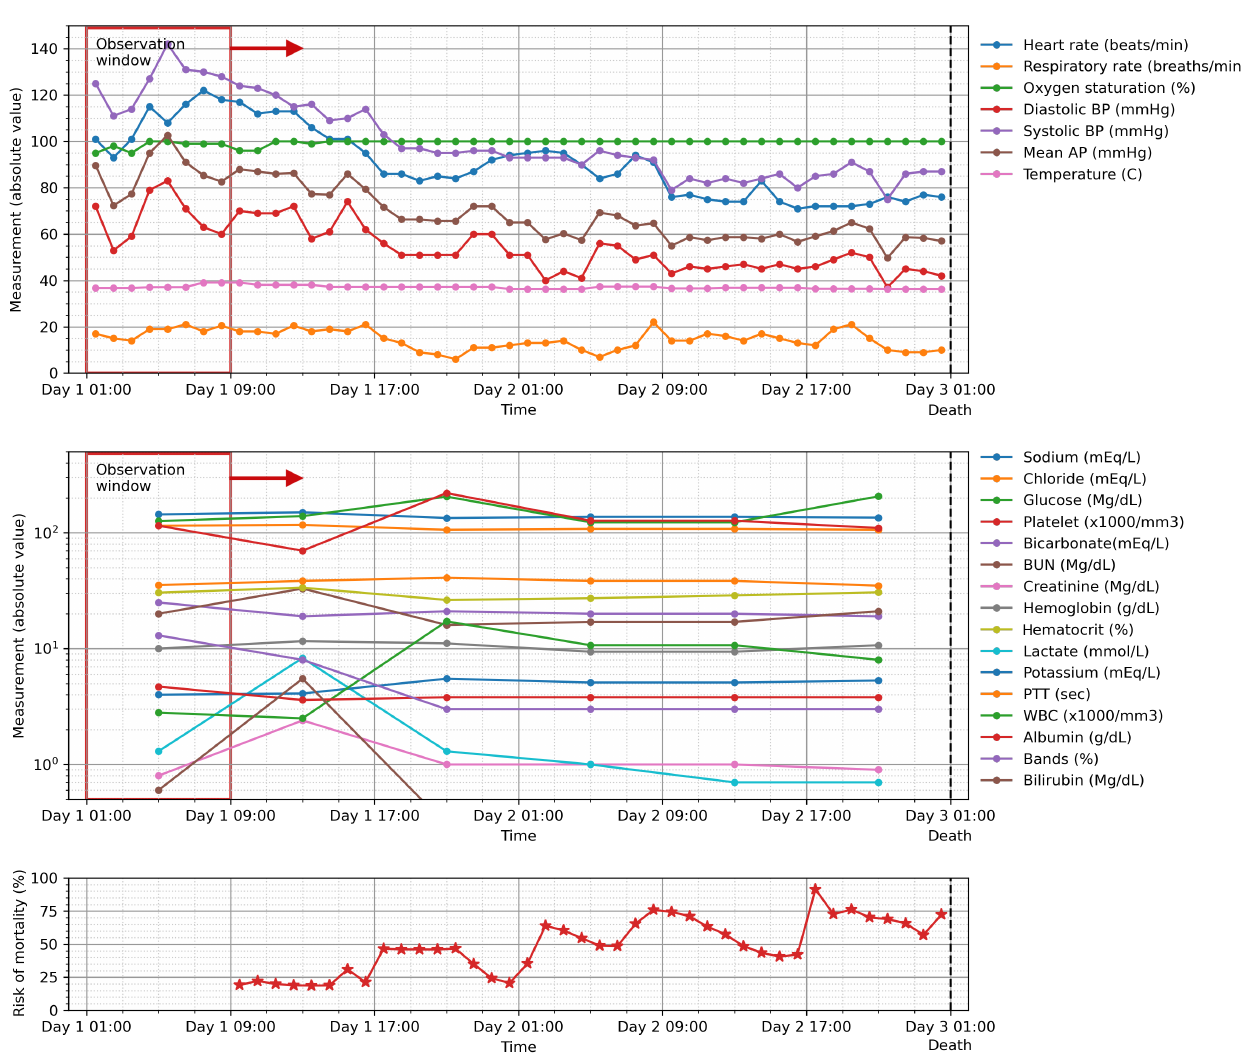
Figure 8. The risk of mortality calculated for a patient who later died during their ICU stay in the hold-out test set computed using the GRU model with an 8-h observation window. The values increased continuously as the patient’s clinical condition worsened until the patient passed away at the end of their